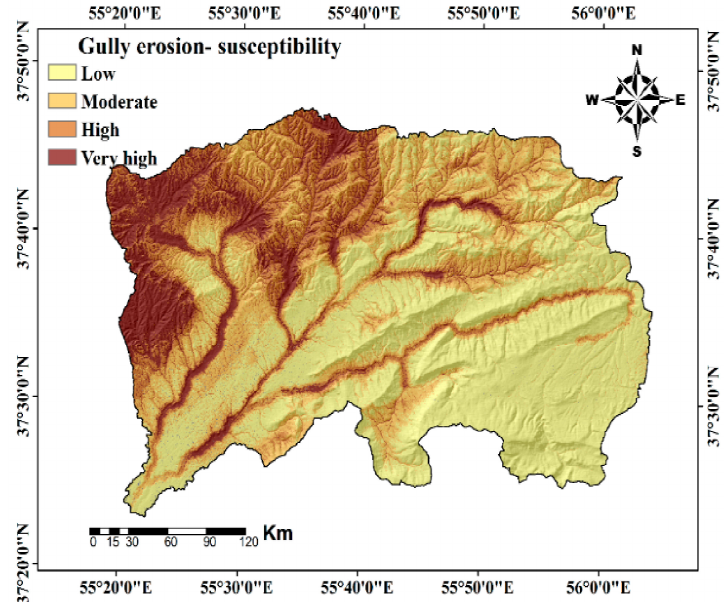
Figure 5. Sensitivity maps of gully erosion of the study area by the MARS model for 70% / 30%, 10